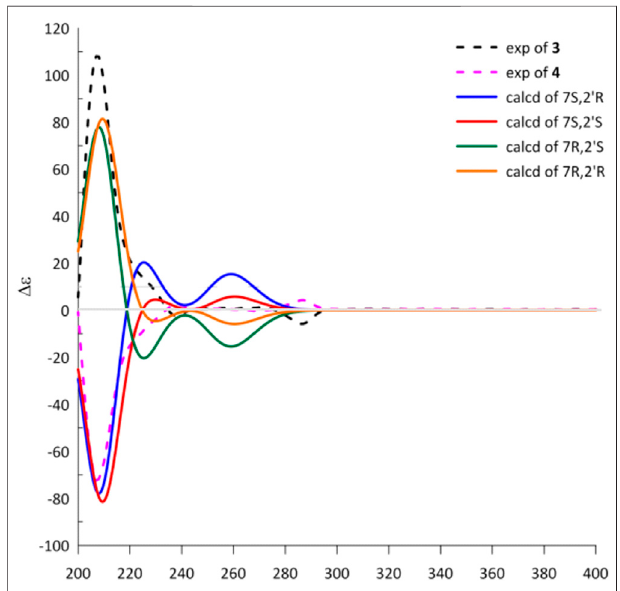
FIGURE 4 | Experimental and calculated ECD spectra of 3 and 4